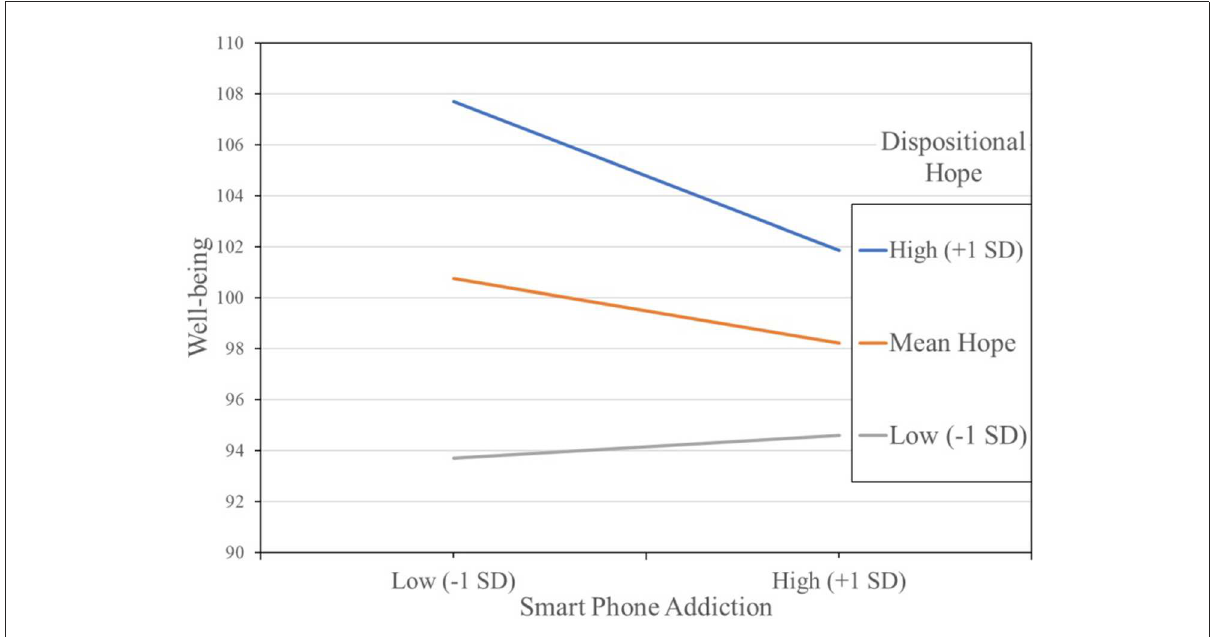
FIGURE3 Effect of hope in the association between smartphone addiction and